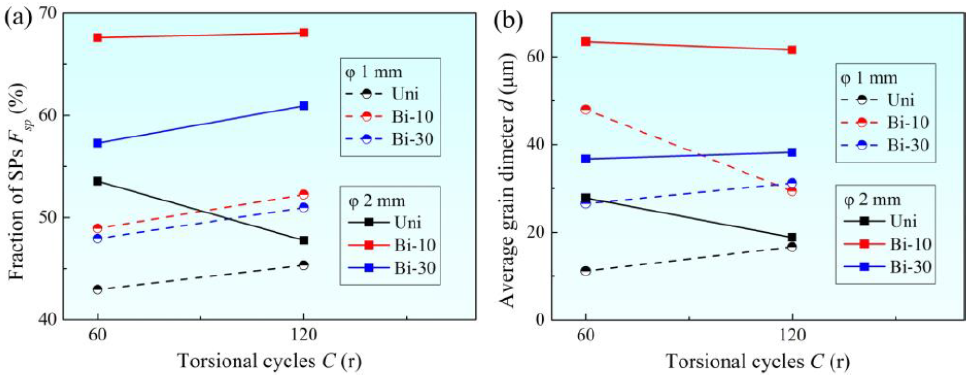
Figure 4. Variations of ( a ) F sp and ( b ) d with torsional cycles.